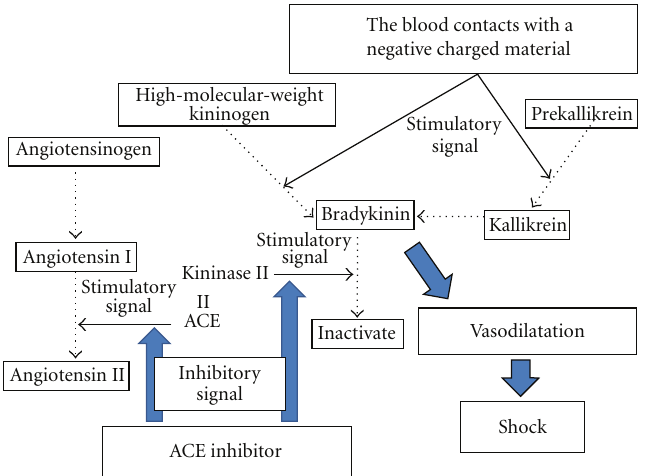
Figure 9: The mechanism of bradykinin-induced anaphylactic shock. When the blood contacts with a negatively charged material, it results in production of Bradykinin (BK) having vasodilating action. The bioactivity of this BK is inactivated by kininase II which is an enzyme identical to ACE. Therefore, the function of kininase II which is an enzyme identical to ACE is inhibited by taking ACE inhibitor and it causes increase in BK concentration in the blood, vasodilatation, and shock symptom being unable to inactivate BK.